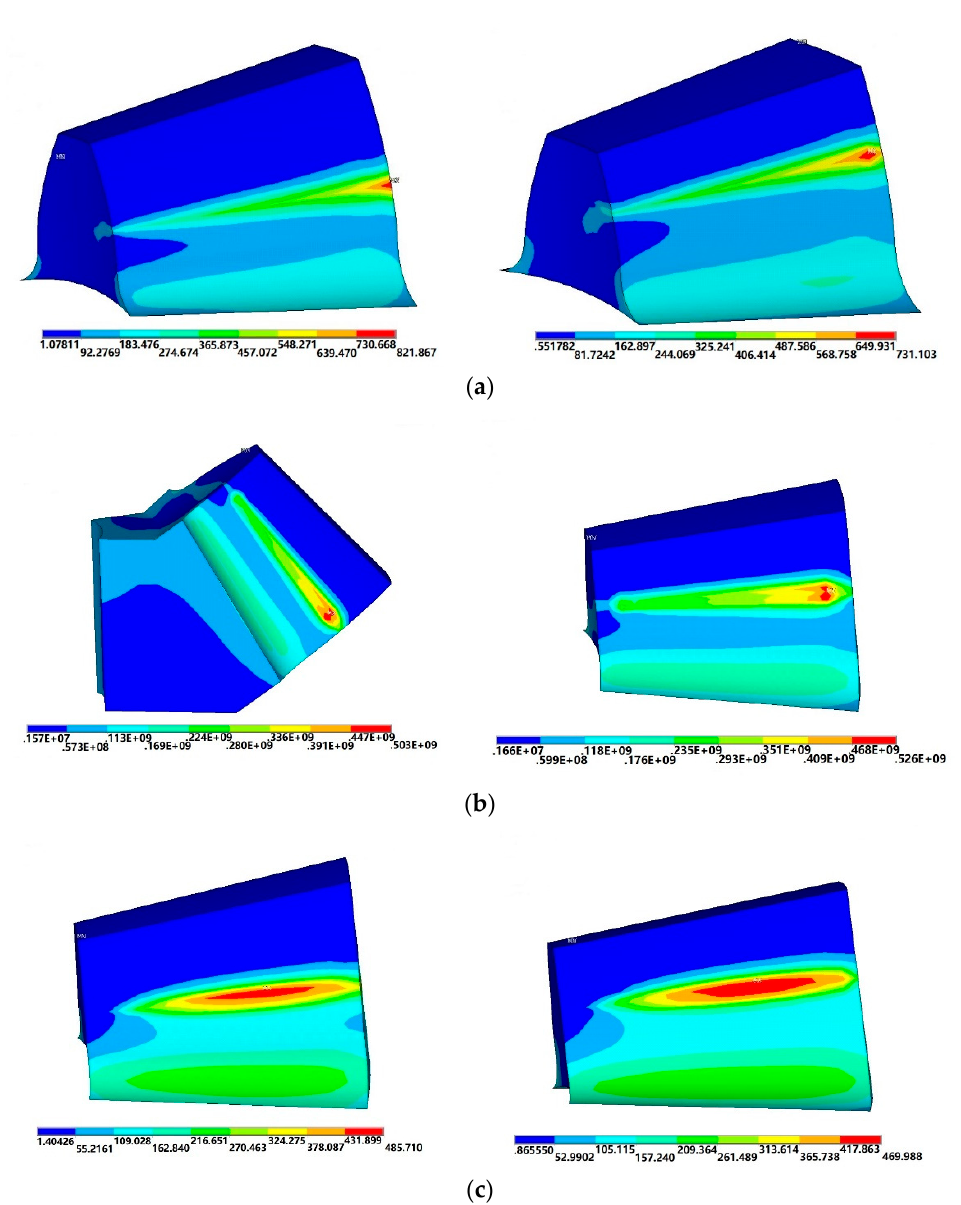
Figure 12. Distribution of contact stress on the tooth surface for pinion (left) and the gear (right) when ∆ G = 0.1. ( a ) No modification, ( b ) Case4 and ( c ) Case1.